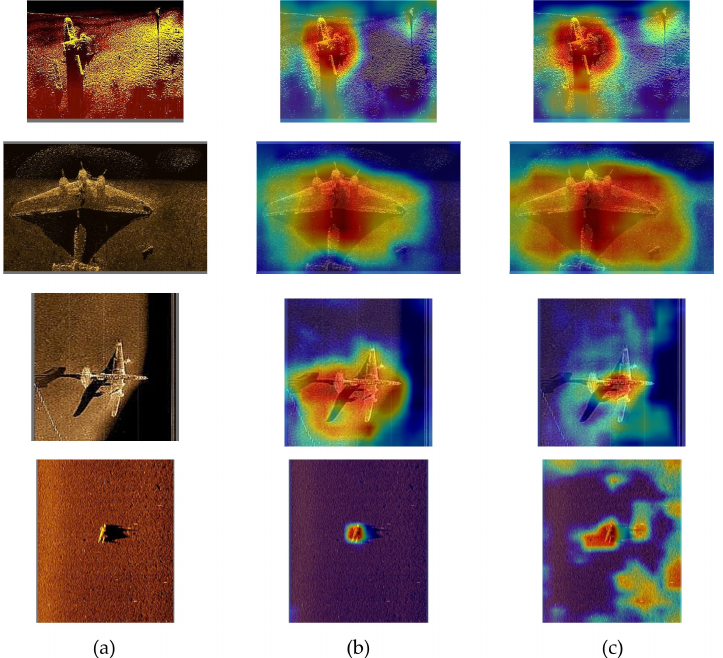
Figure 12. Detection results with heatmap. ( a ) Original images; ( b ) detection with a CE feature encoder; and ( c ) detection of the original network.